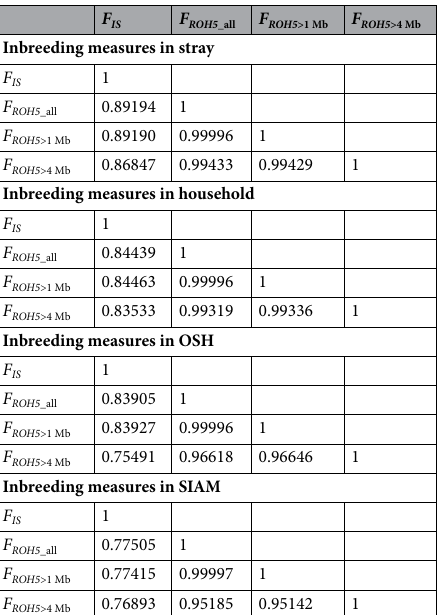
Table 4. Pearson correlation coefficients between genomic inbreeding coefficient F ROH5 based on different ROH lengths (all, > 1 Mb and > 4 Mb) and fixation index F IS by the four populations.